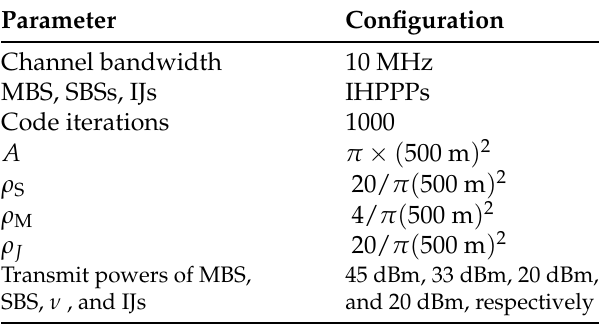
Table 3. Simulation Parameters.